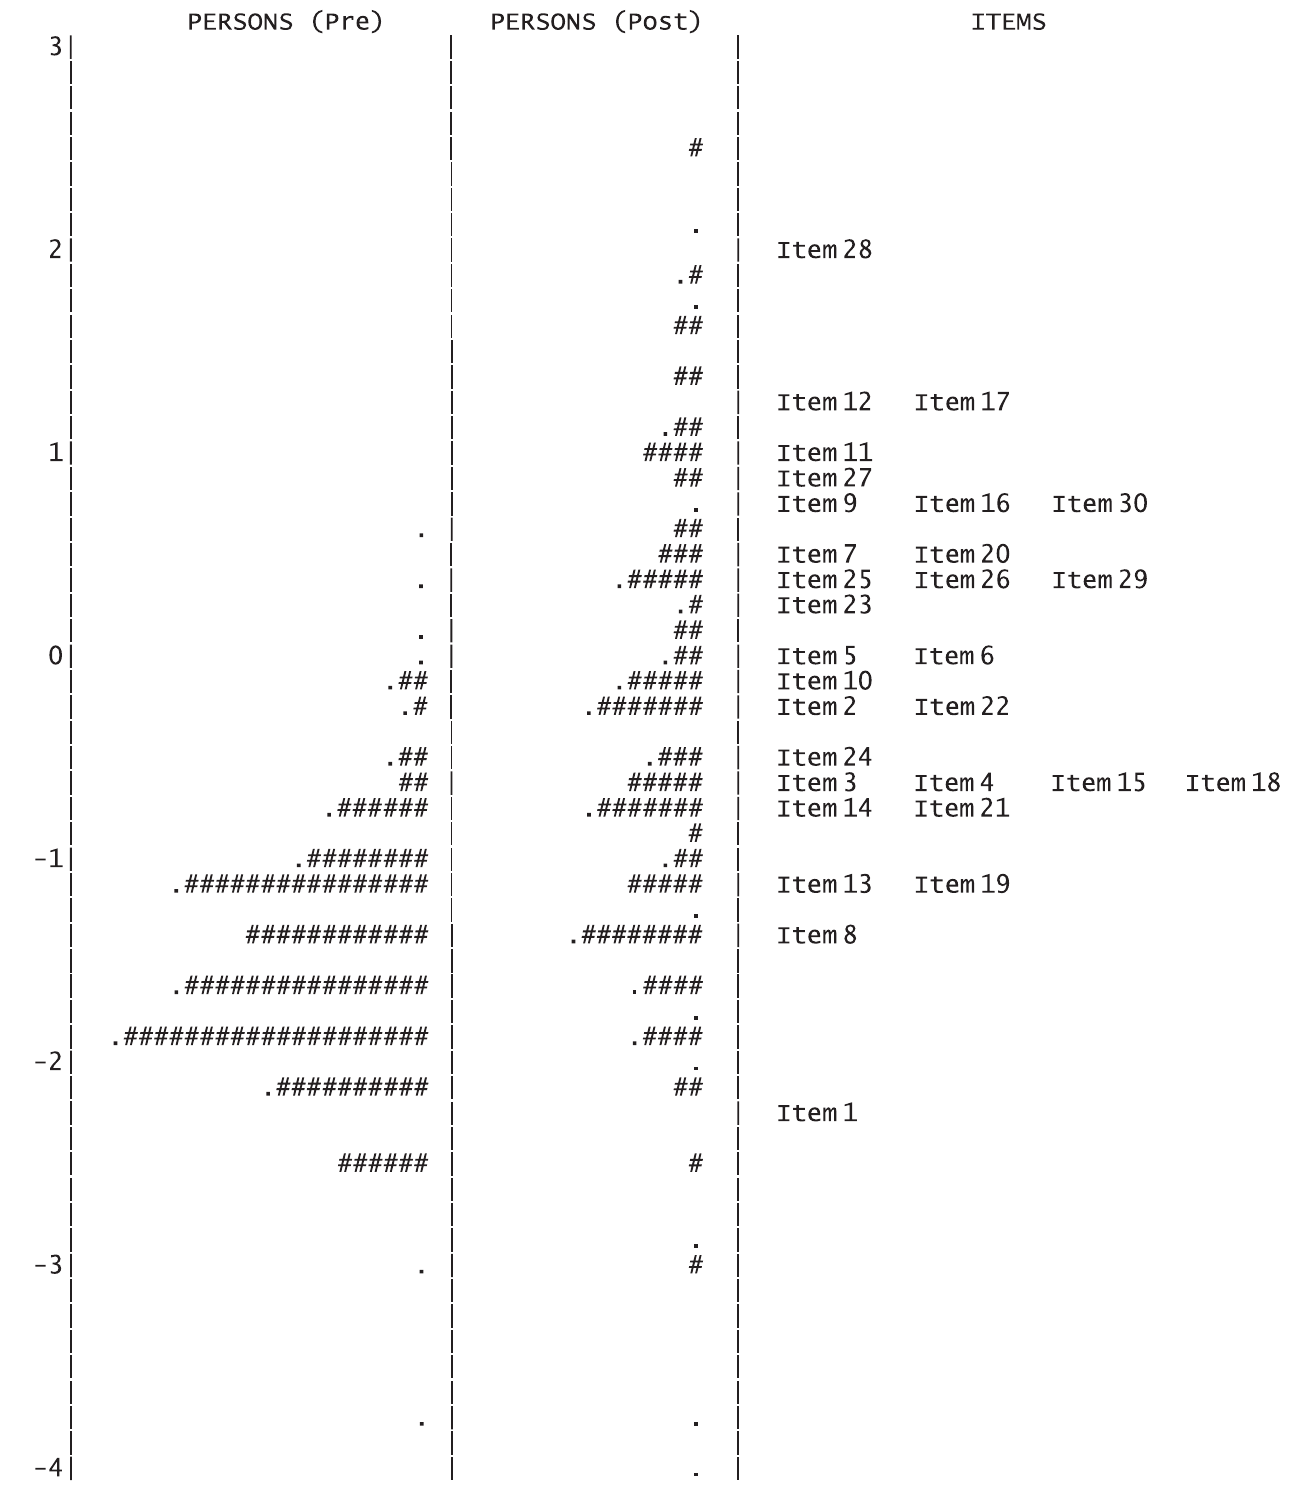
FIG. 2. A BEMAWright map based on all data. On the left-hand side of the logit scale are two columns of student ability distribution; on the right-hand side of the logit scale is the item difficulty